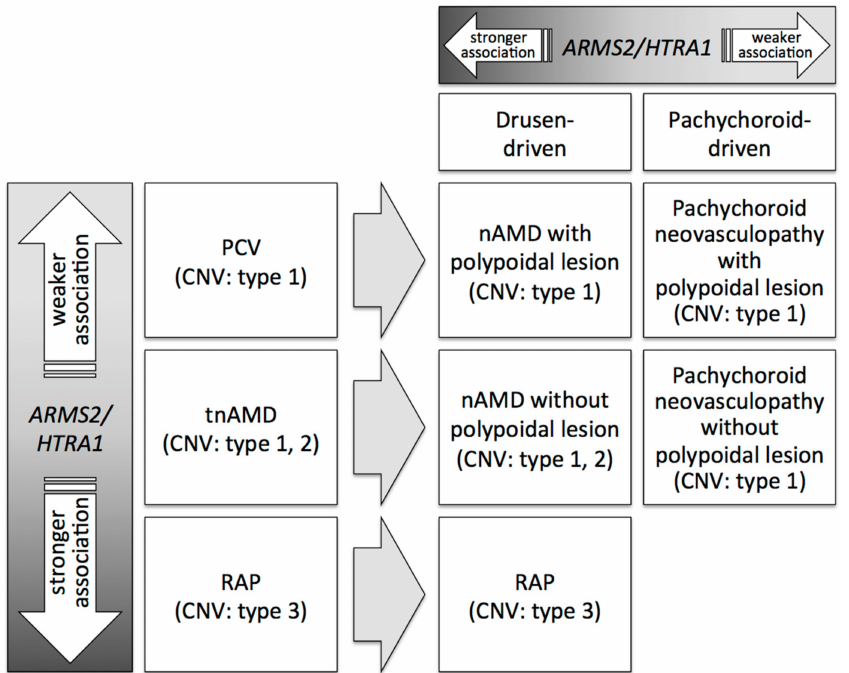
Figure 5. Associations of ARMS2 / HTRA1 with subtypes of age-related macular degeneration (AMD) before and after introduction of the pachychoroid concept. Before the pachychoroid concept, AMD was divided into three subtypes of polypoidal choroidal vasculopathy (PCV), typical neovascular AMD (tnAMD), and retinal angiomatous proliferation (RAP). The association of ARMS2 / HTRA1 is weaker for PCV and stronger for RAP than tnAMD. After the pachychoroid concept, PCV is further divided into the drusen-driven type and pachychoroid-driven type, and tnAMD is also divided into the drusen-driven type and pachychoroid-driven